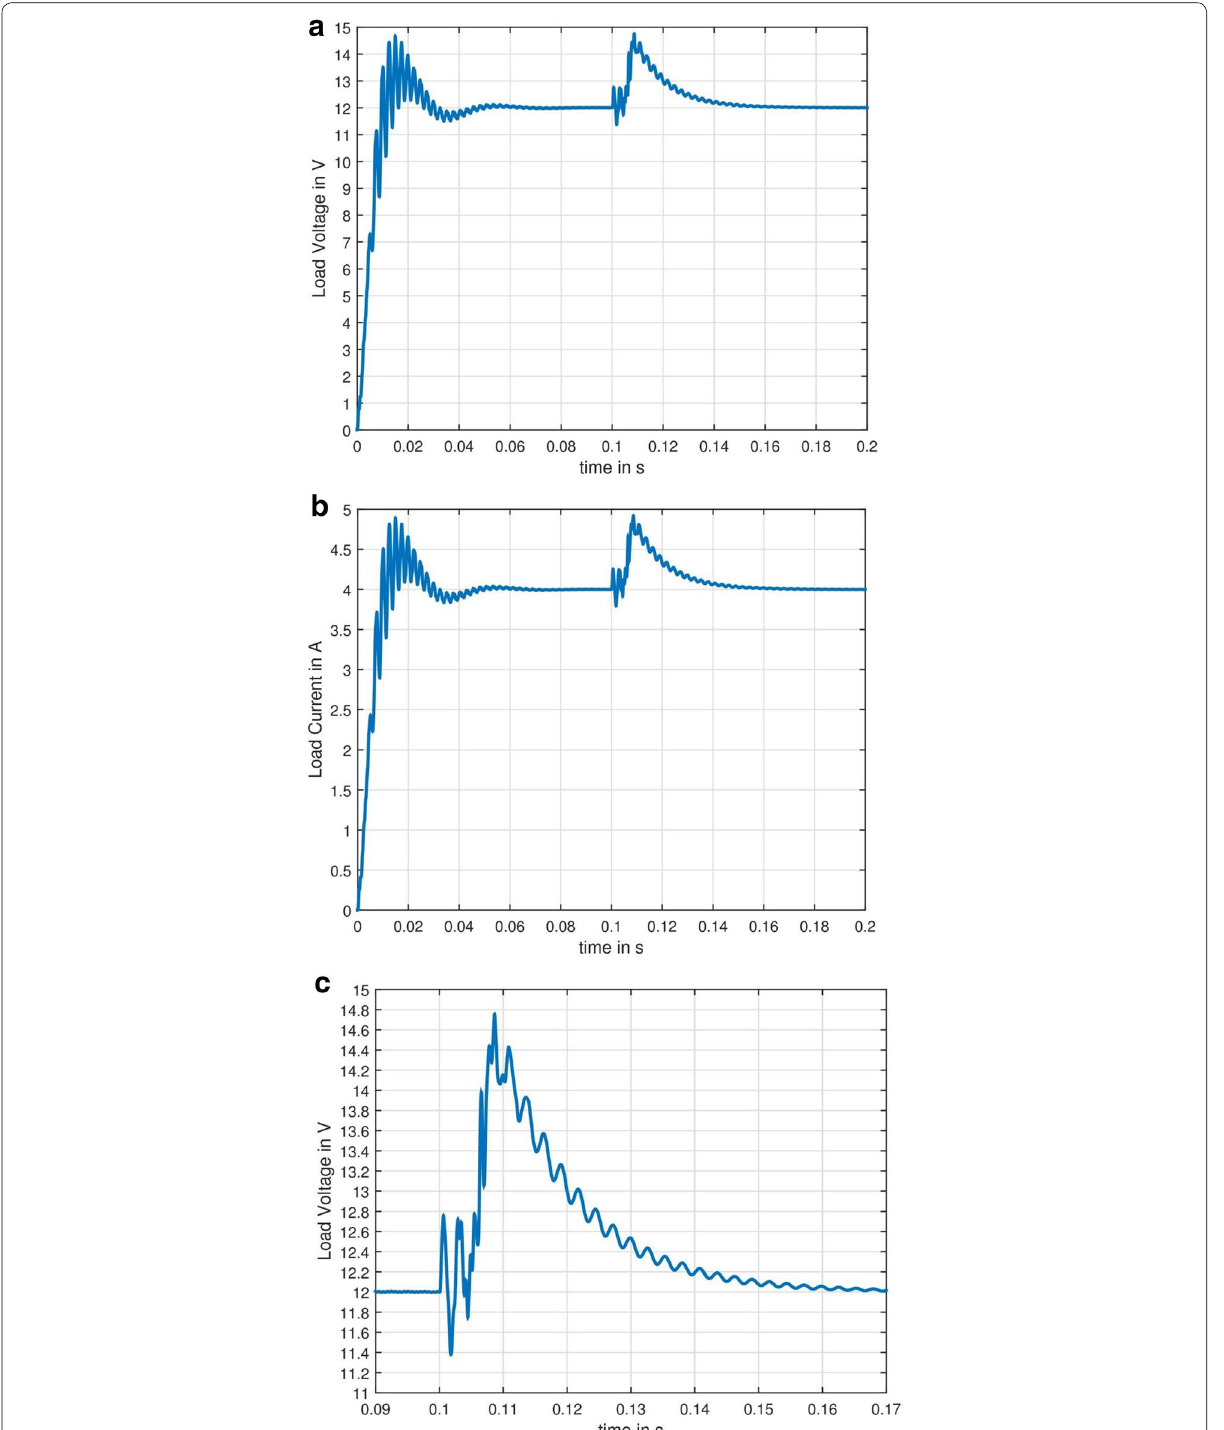
Fig. 8 a Voltage across the RepRap. b Current through the RepRap. c Zoomed in on voltage across RepRap during the transition from PV to